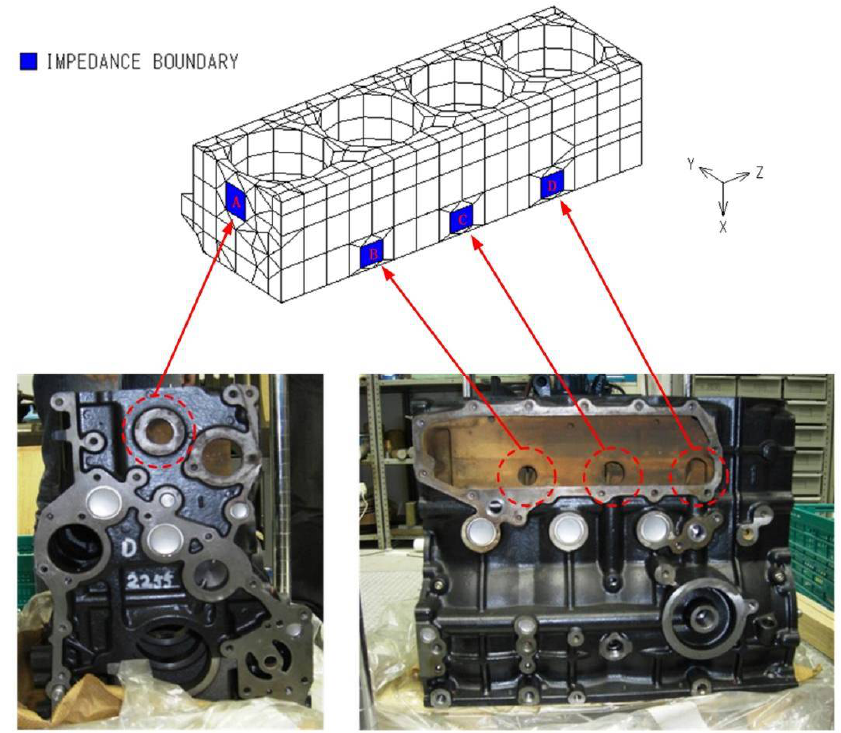
Figure 12. Appearance of water jacket model with impedance boundary.